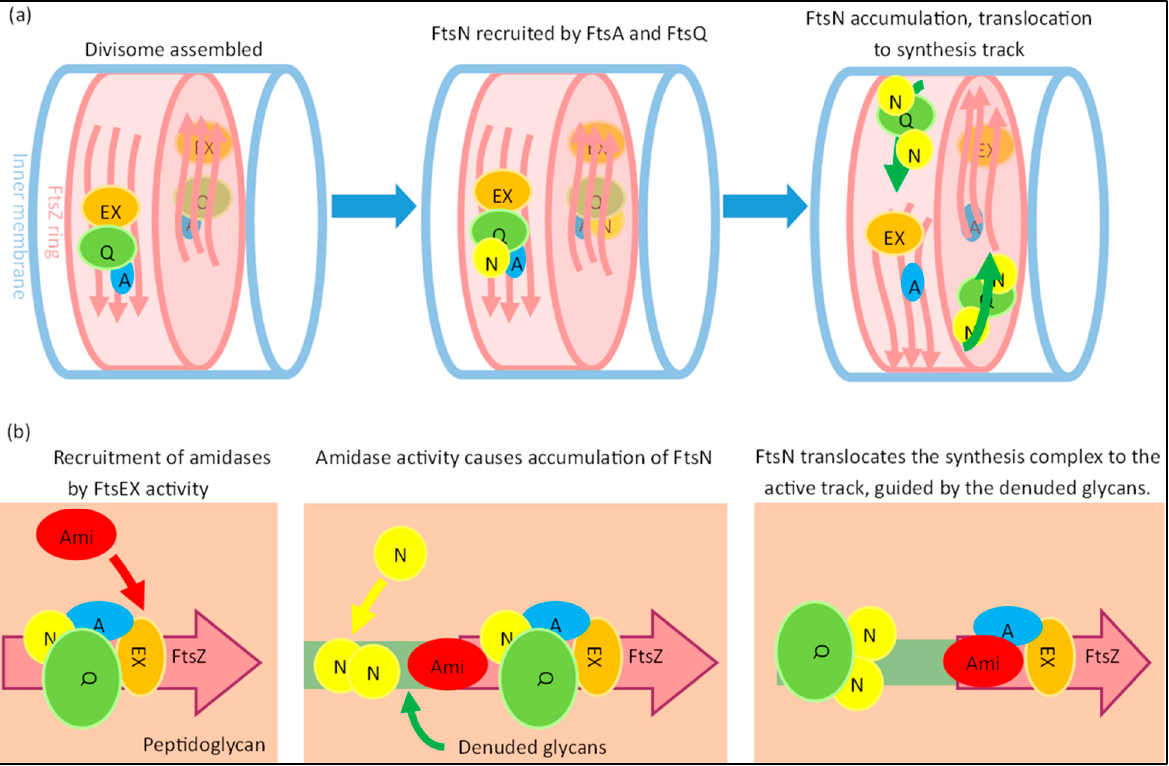
Figure 9. FtsN active track formation. ( a ) A simplified model describing the possible formation of the FtsN-associated active track is shown. When the divisome is completely assembled, FtsN (N; yellow) can be recruited to the division site. FtsN is likely recruited by direct interactions with FtsA (A; blue) and FtsQ (Q; green). FtsEX (EX; orange) ATPase activity of FtsEX leads to the recruitment of amidases (Ami; red), which form denuded glycans. The SPOR domain of FtsN binds to the denuded glycans, leading to the accumulation of FtsN at the septum. FtsN, together with the synthesis complex represented by FtsQ, then translocates to the slower, active track away from the faster FtsZ-associated track. ( b ) The active track is proposed to be ‘carved’ out in the septal peptidoglycan by the amidases activated by FtsEX, which tightly interact with FtsZ from its recruitment. This mechanism describes how the presumed translocation of the synthesis complex may occur. This links the FtsN-track and FtsZ-track spatially, in line with experimental data. The pink arrows indicate the dynamics of FtsZ filament bundles, and the green arrows at the top indicate the dynamics of the active FtsN-associated track.